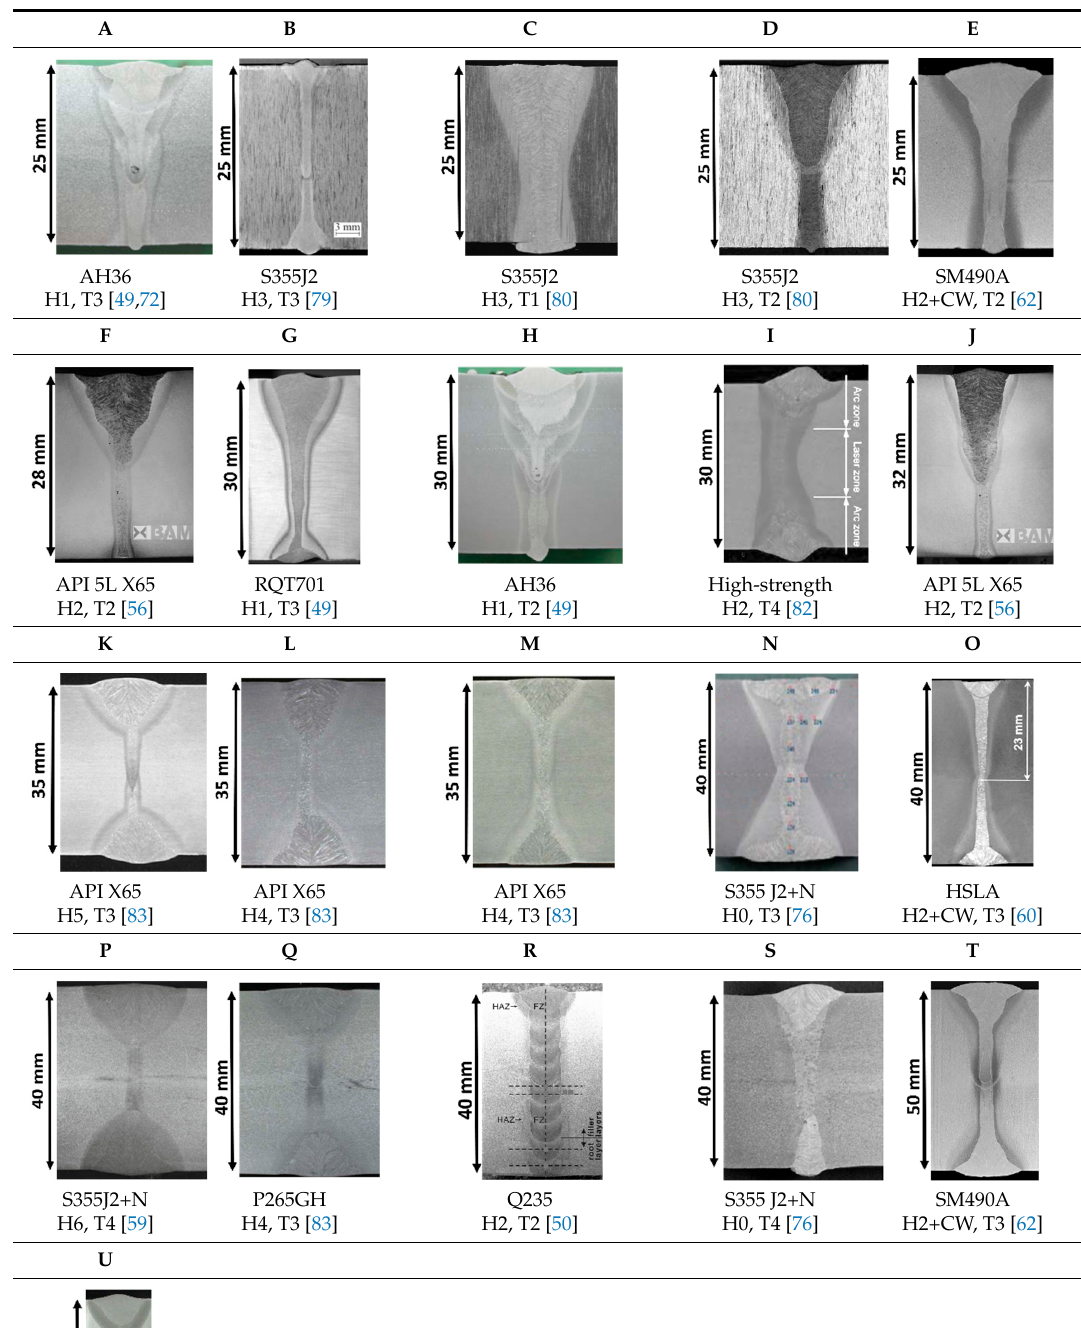
Table 11. Cross sections of the thick steel hybrid laser joints.